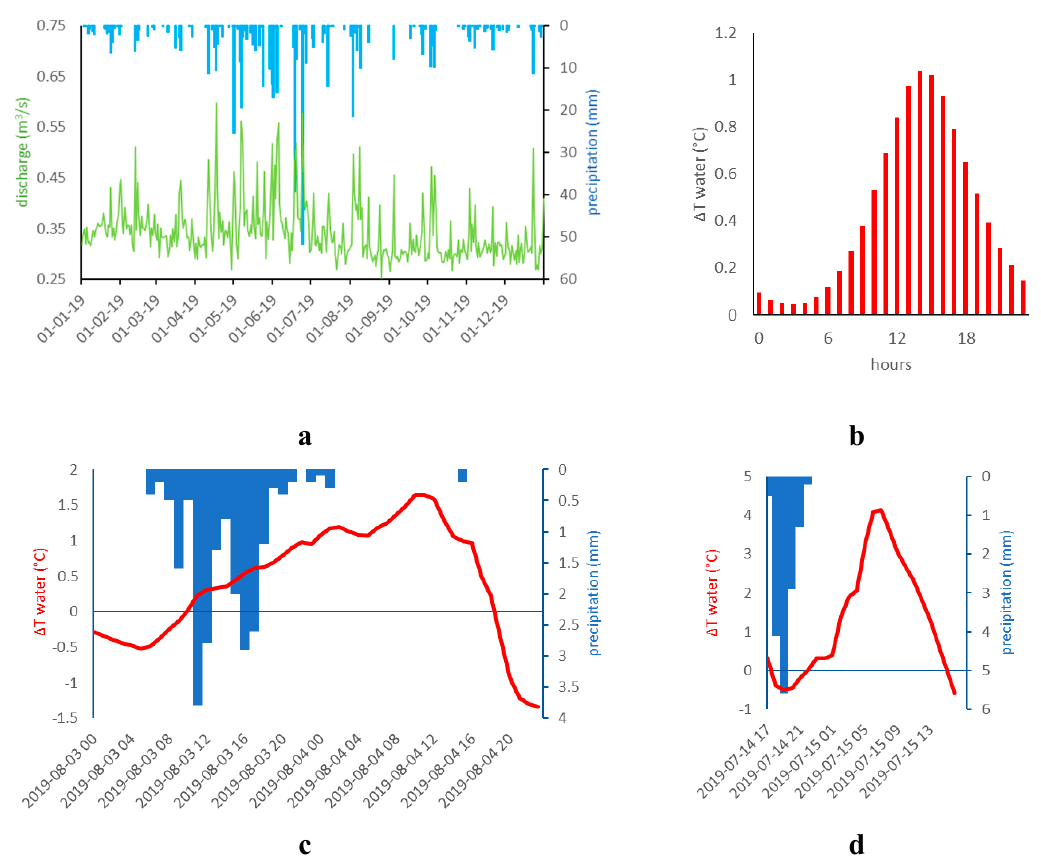
Figure 11. Links between rainfalls, wastewaters and the water temperature of Suceava River: ( a ) correlation between the rainfall amount and the wastewater treatment plant discharge, ( b ) average diurnal profile of Suceava River water temperature difference (downstream–upstream), ( c ) Suceava River water temperature difference (downstream–upstream) versus atmospheric precipitation at Suceava Weather Station during 3–4 August 2019 (48 h), ( d ) same as in ( c ), but during 14–15 July 2019 (24 h).